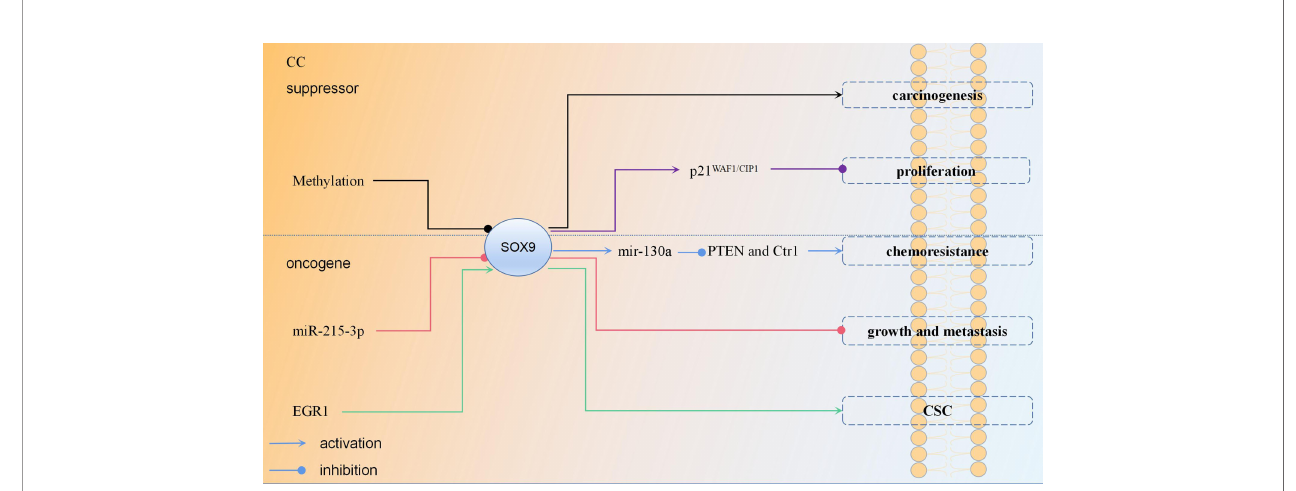
FIGURE 3 | The regulation mechanism of SOX9 in cervical cancer each color represent a regulation mechanism of SOX9